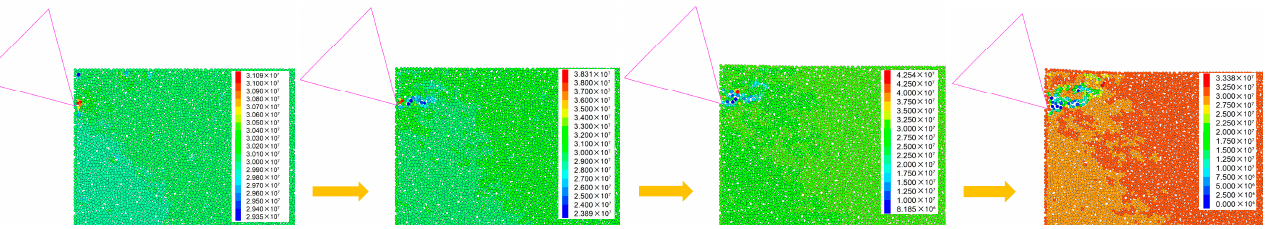
12 of 19 Figure 9. Fluid force applied to particles.